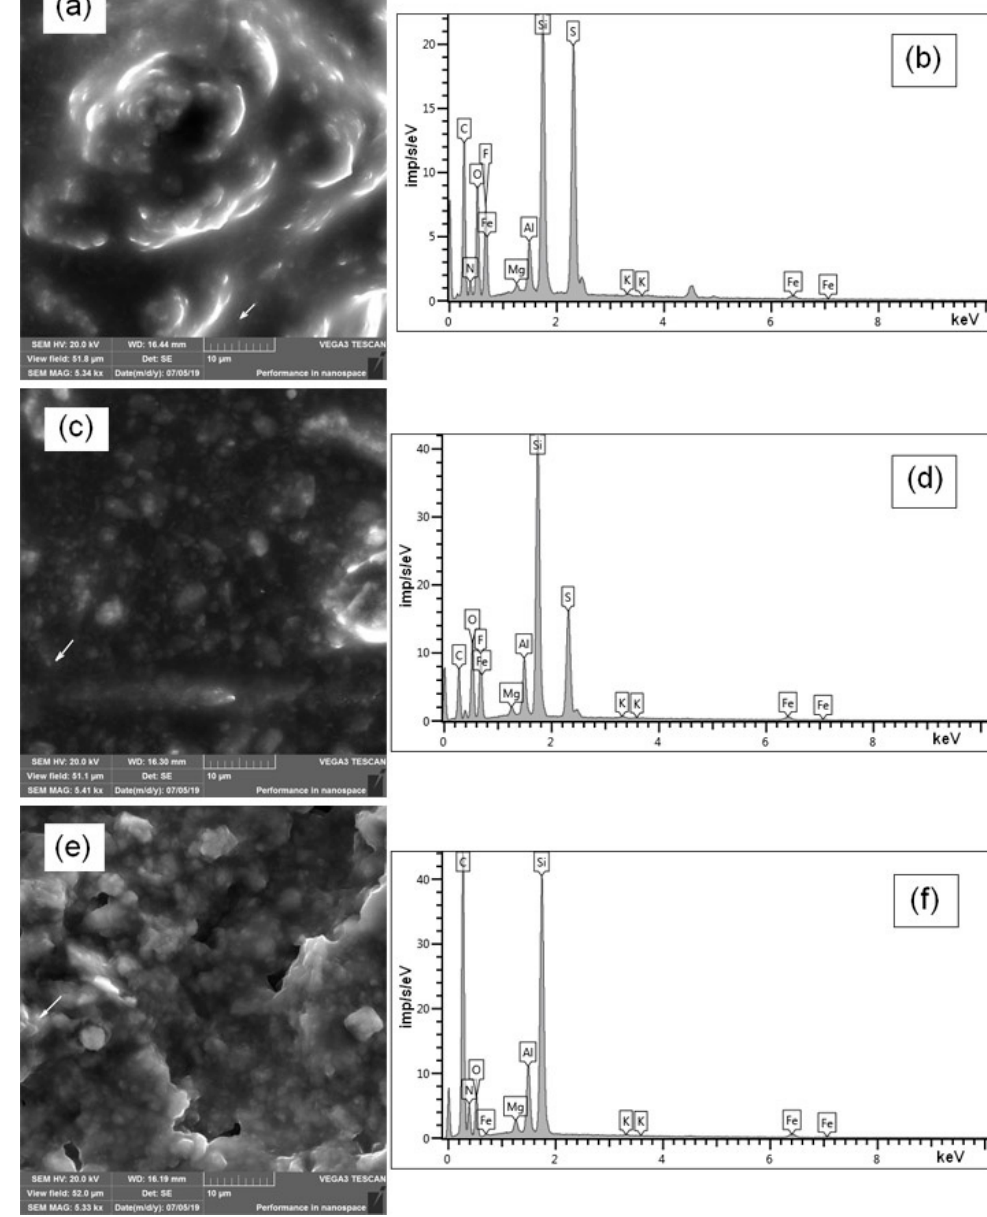
Figure 4. SEM-images (left) and EDX analysis (right) of the samples of MMT K10/BMImOTf ( a , b ), MMT K10/BMImDCA ( c , d ), and MMT K10/BMImNTf 2 ( e , f